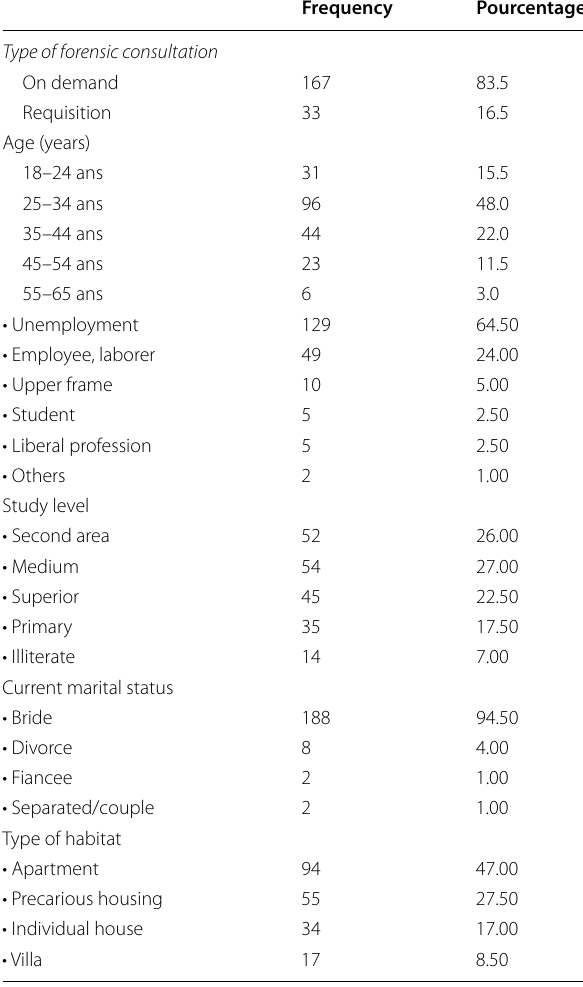
Table 1 Socio-professional and demographic characteristics of the study population ( n =